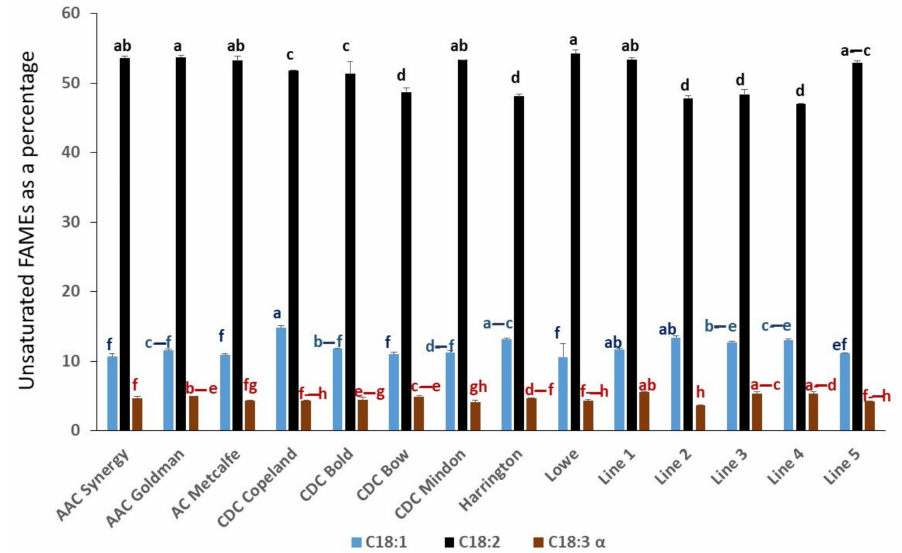
Figure 1. GC/MS analysis of barley cultivars and elite germplasm. Unsaturated FAMEs composition in grain samples is shown. Values sharing the same letter/s in the bars of the same color are not significantly different at the level ≤ 0.05 using Tukey test.